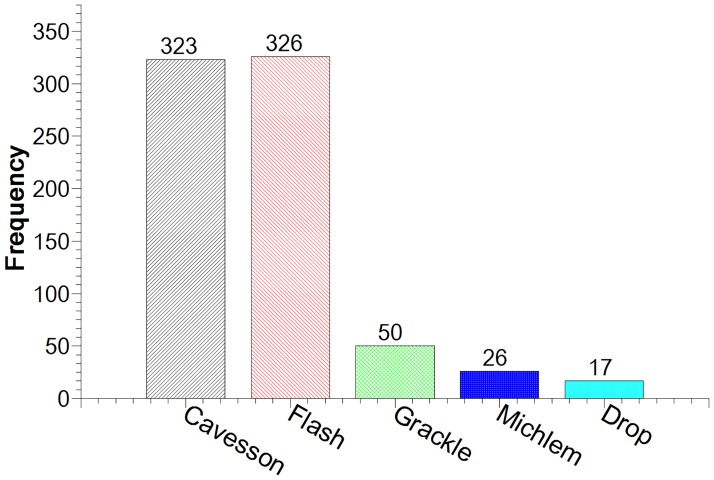
Frequency of usage of five different noseband types.